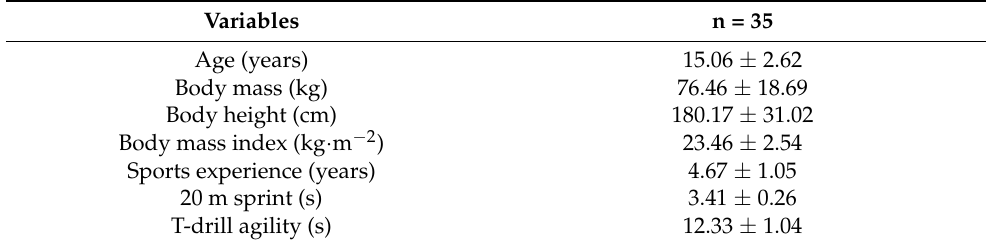
Table 1. Baseline characteristics of the athletes (Mean ±